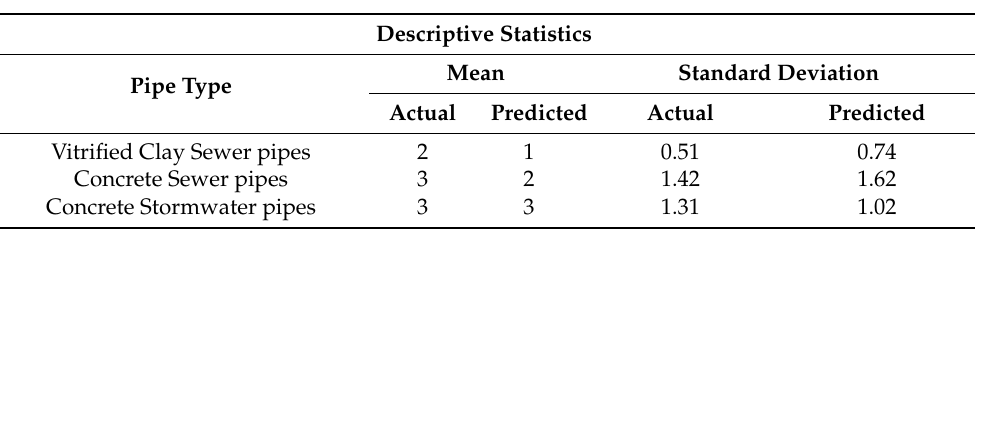
Table 6. Descriptive statistics for model